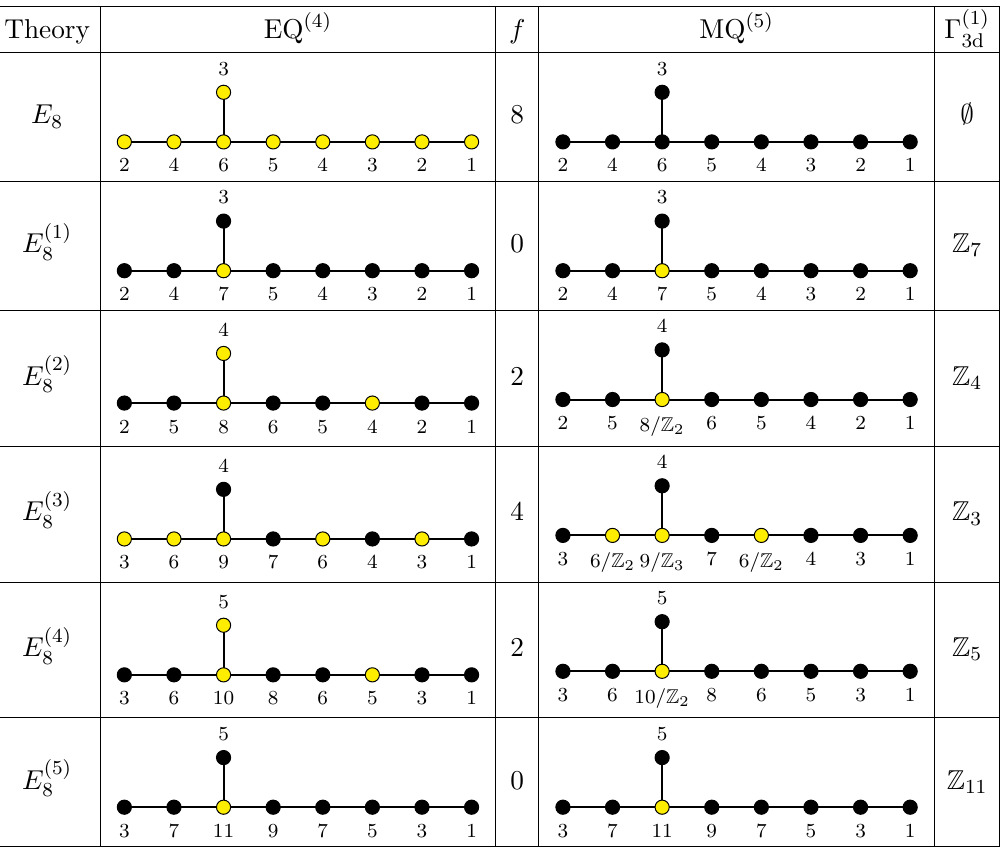
Table 6 . EQ (4) and MQ (5) for the r = 1 E 8 series of theories and their 1-form